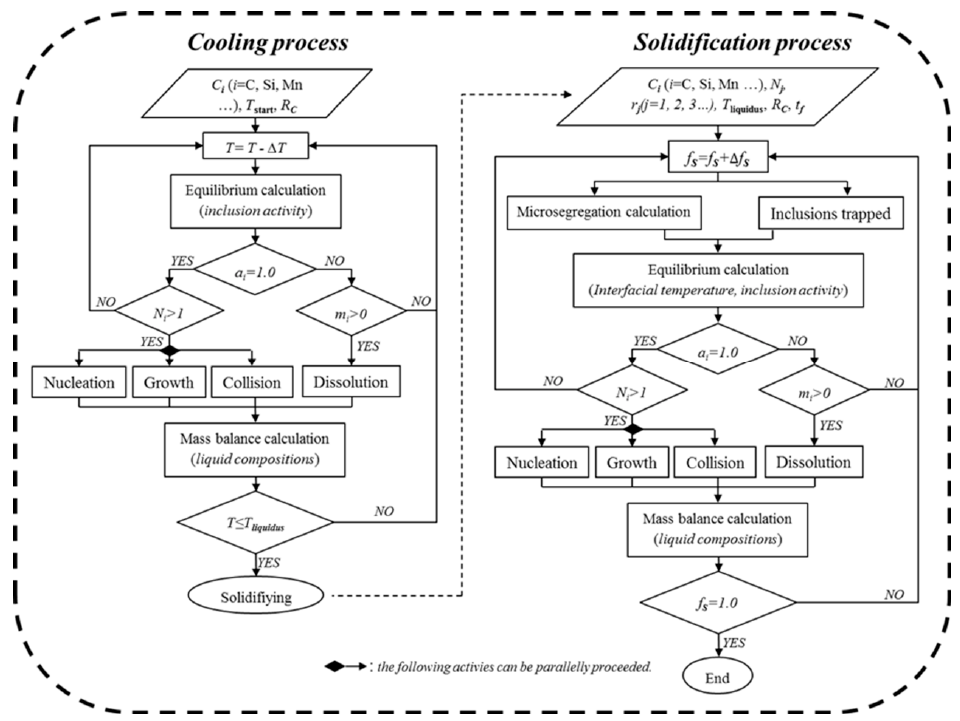
Figure 2. The flow chart of the comprehensive model of the formation of multi-phase inclusions during the cooling and solidification of steel. Table 1. Parameters applied in the comprehensive model of the formation of multi-type inclusions